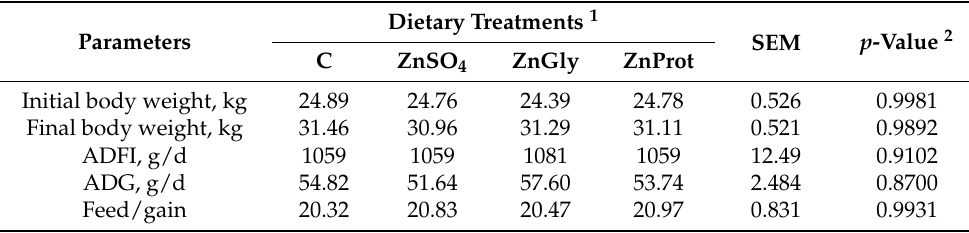
Table 2. Growth performance of lambs for the 120 day feeding period differing in Zn source (80 mg Zn/kg). ADFI: average daily feed intake; ADG: average daily